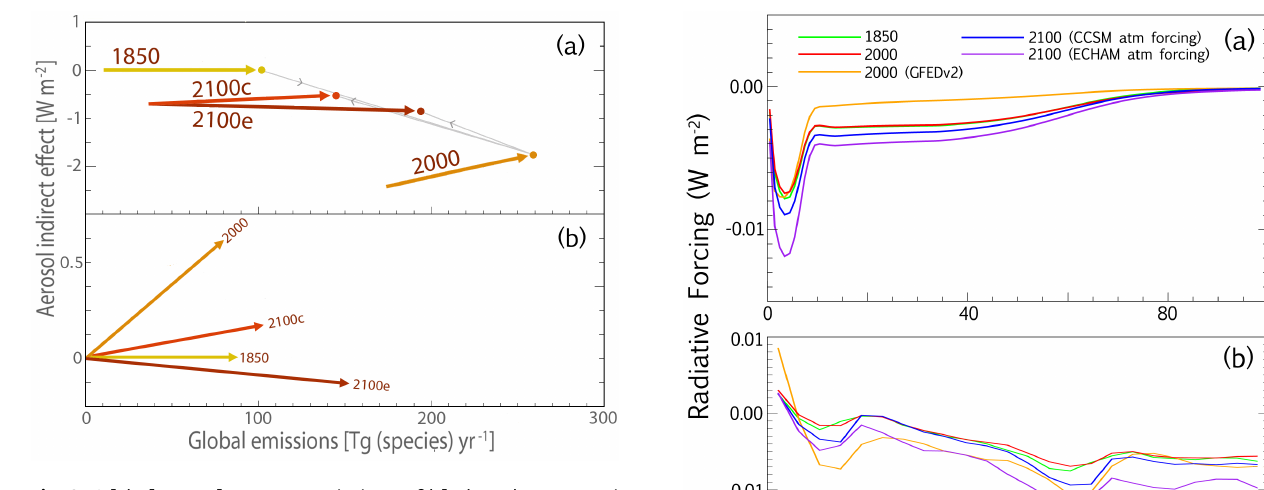
Fig. 8. Global annual average emissions of black carbon, organic carbon, and SO 2 (assumed to convert to SO 4 ) plotted against the aerosol indirect effects computed from CAM5 for all time periods and both future atmospheric forcings (2100c for the Community Climate System Model atmospheric forcing, and 2100e for the ECHAM5 atmospheric forcing), represented as coloured circles in a). The coloured arrows trace the change due to fire aerosols. In a), the change in indirect effects is referenced against pre-industrial values of 0 W m -2 with and without fires. The grey lines show the path from time period to time period. The arrows in b) are given relative to each other, highlighting the change in angle between the fire impacts in the different time periods.